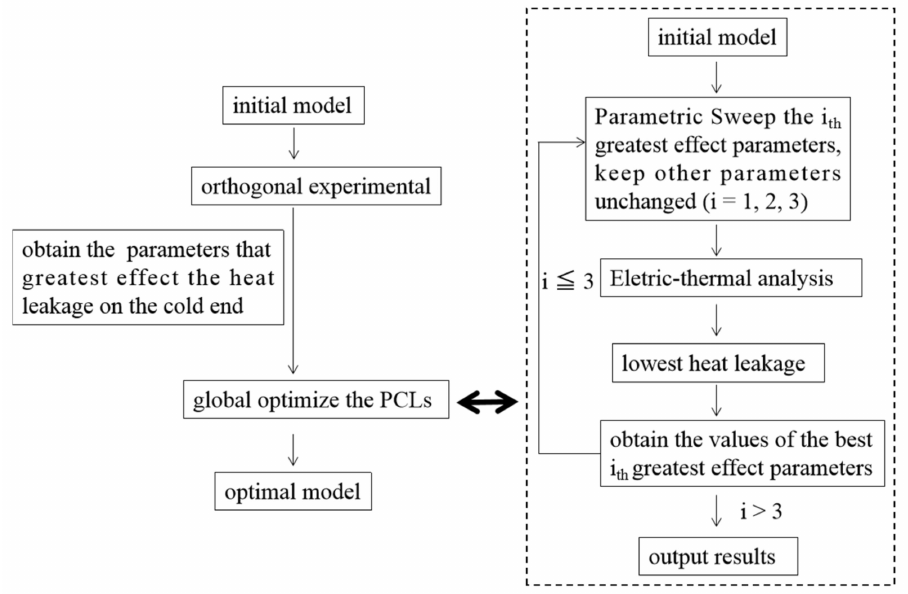
Figure 3. Global optimization